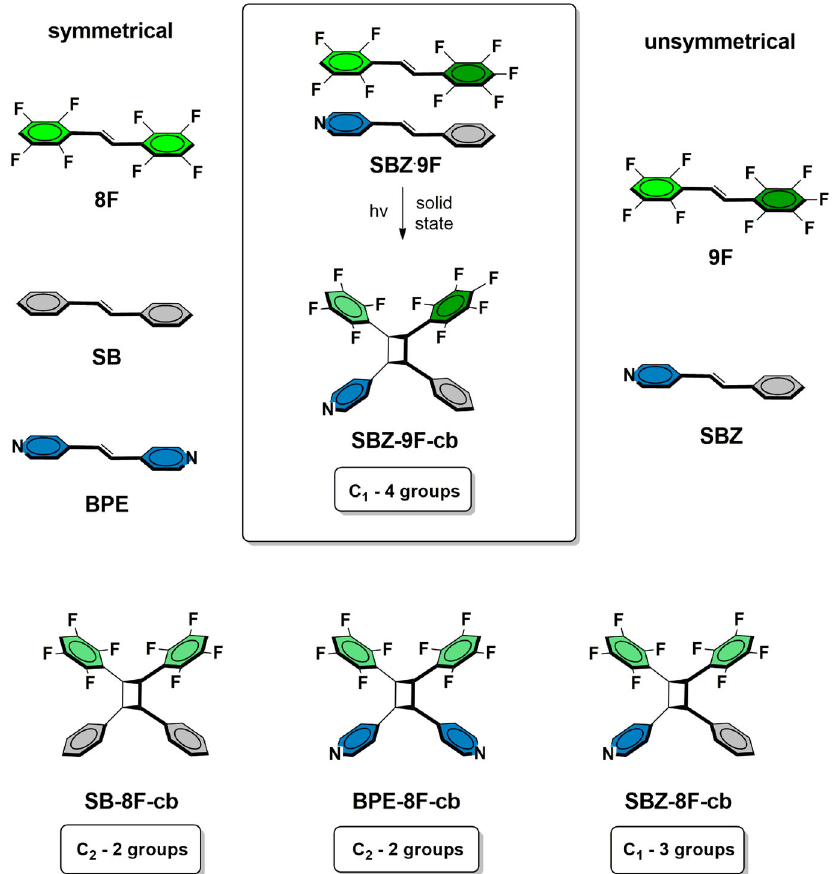
Fig. 2 Cross-photoreactions studied to generate a cyclobutane with up to four different substituents. Per fl uorophenyl-phenyl and H-per fl uorophenyl- pyridyl stacking directs the assembly of C = C